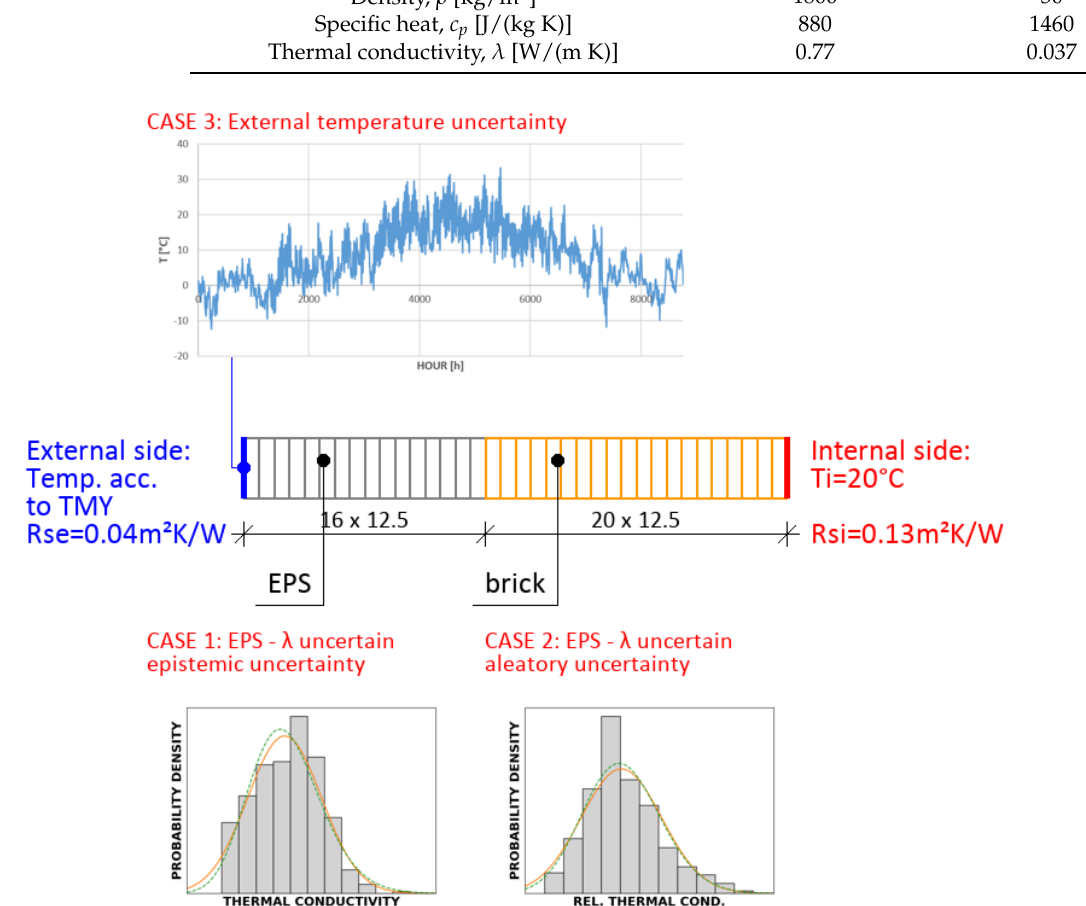
Figure 2. Scheme of the geometry, boundary conditions and uncertainties considered in the numerical